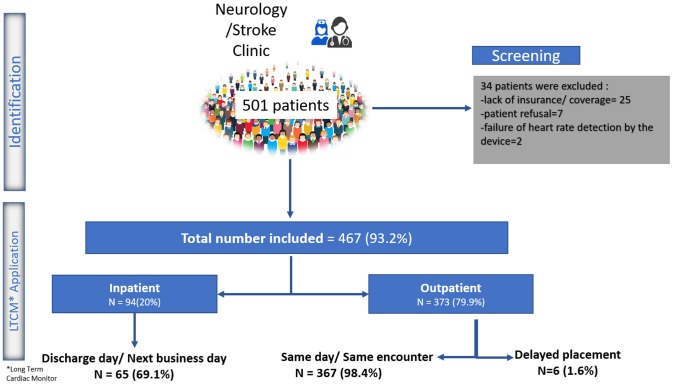
Study flow diagram.